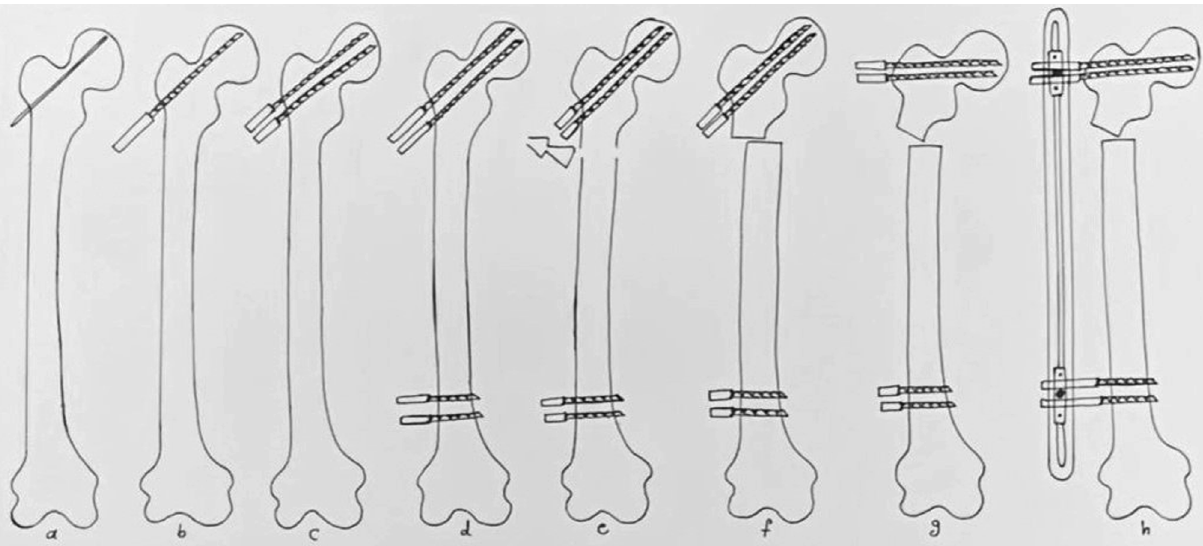
Figure 7. Graphical illustration summary of the technique: (a) K-wire insertion; (b) replacement of the K-wire by a pin; (c) adding one more proximal pin; (d) insertion of proximal pins; (e) performing percutaneous osteotomy; (f) bone shifting following osteotomy rule 2; (g) varisation, making the proximal pins parallel to the distal ones; (h) connecting the pins to the external fi xator.